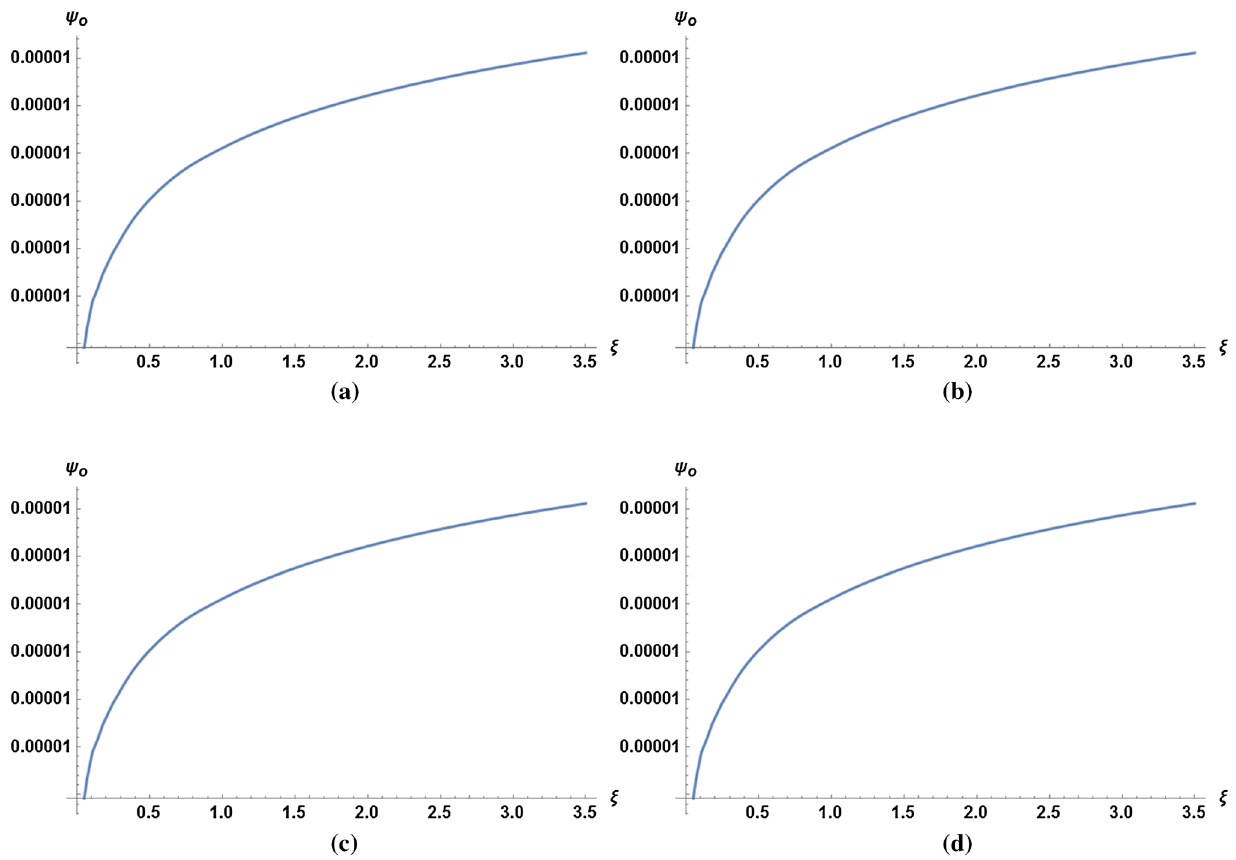
Fig. 2 Graphs between ξ and ψ o ; for α 1 = . 5, n = 1 and α = 10 − 10 (curve a ); α = 2 × 10 − 10 (curve b ); α = 4 × 10 − 10 (curve c ) and α = 4 × 10 − 10 (curve d